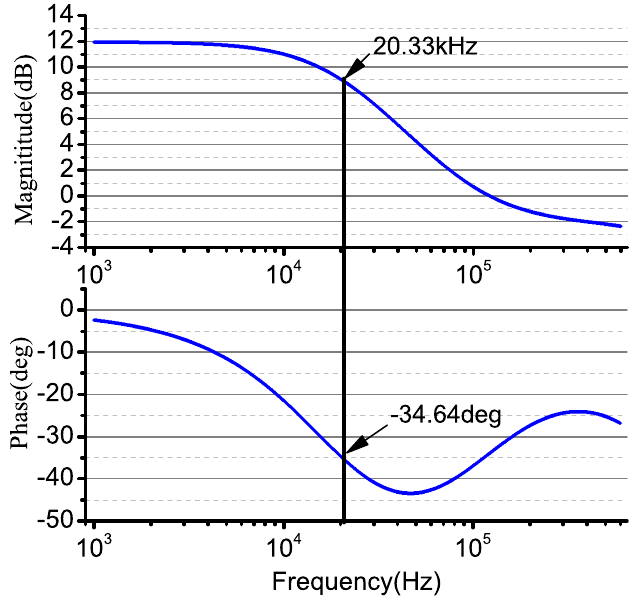
Figure 8. The Bode plot of the signal conditioning system in the driving